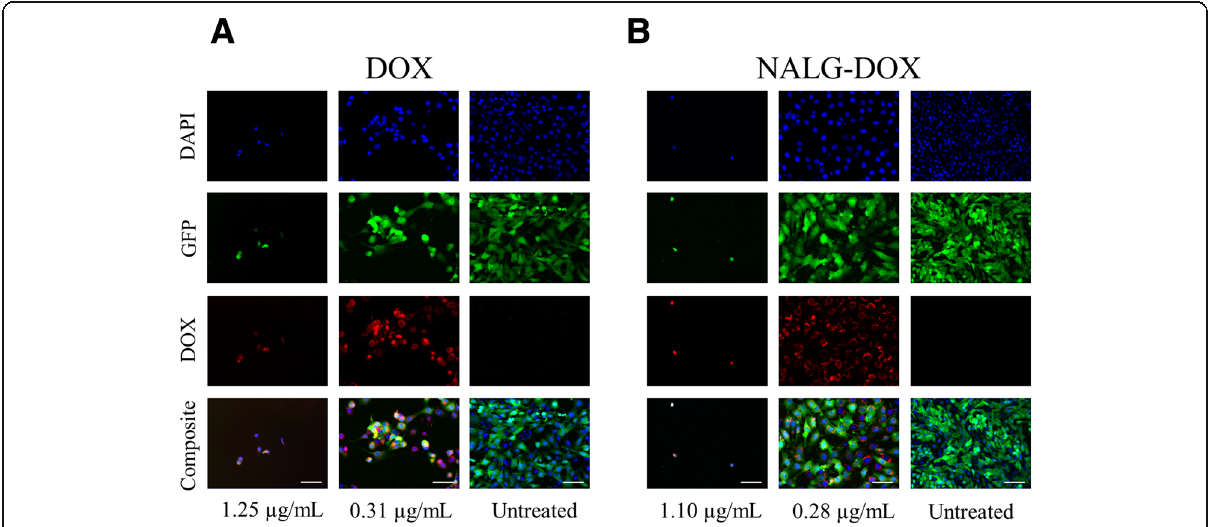
Fig. 4 Fluorescence microscopy of images of fixed 4T1-luc2-GFP breast cancer cells treated with doxorubicin (DOX) ( a ) and NALG-DOX ( b ) after 48-h exposure. Scale bars indicate 100 μ m. Blue nuclear stain: DAPI; green (transfected cell line): GFP; red (intrinsic molecular fluorescence):